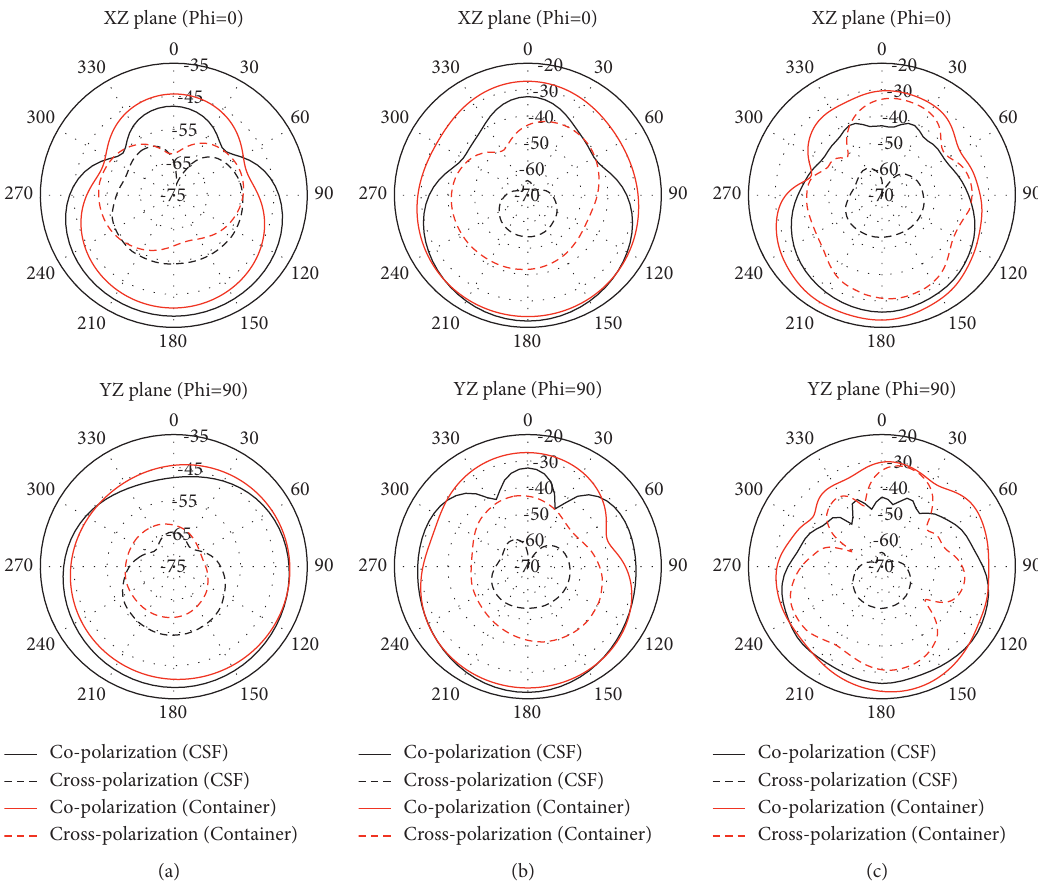
Figure 11: 2D simulated co- and cross-polarization of the antenna gain pattern (dBi) in 7-layer head model and container at the XZ plane and YZ plane. (a) 402MHz, (b) 902MHz, and (c) 2400MHz.